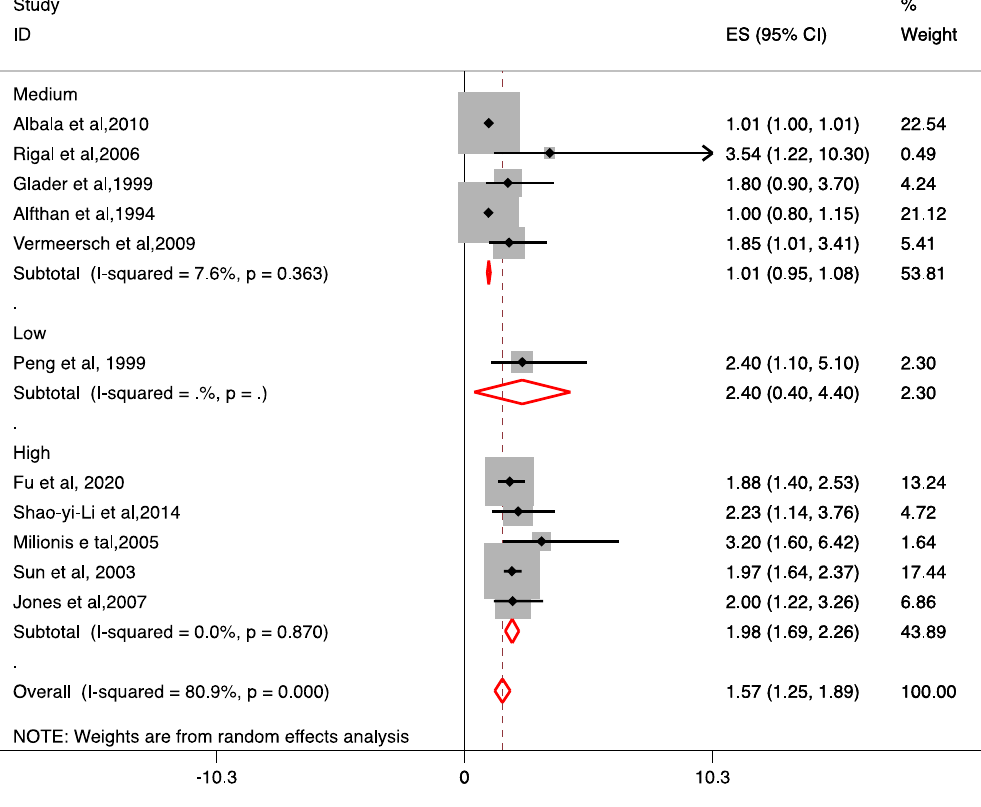
Figure 3. Forest plot for the association of Lp (a) level with the risk of Ischemic stroke vs. control for the reported Odds ratio in the included studies based on NOS quality grading.